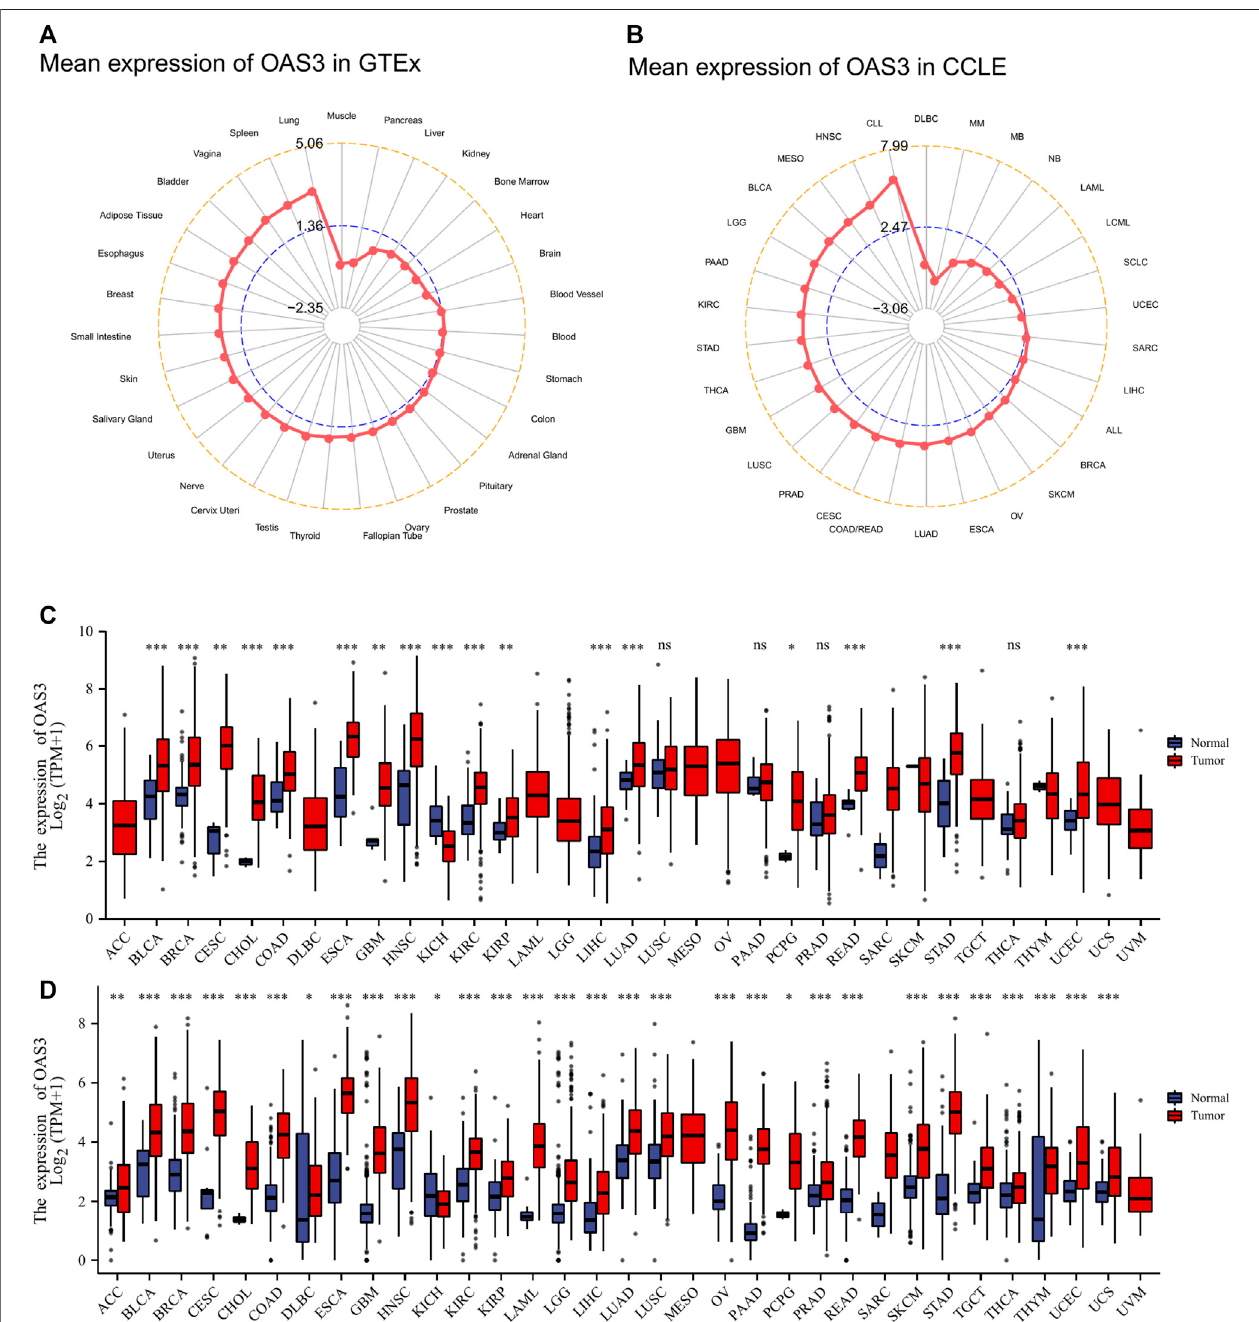
FIGURE 2 | (A) : OAS3 mRNA expressions in various normal human tissues from the GTEx database. OAS3 is most highly expressed in lung and least expressed in muscle. (B) : OAS3 mRNA expressions from the CCLE database. The results showed that OAS3 was highly expressed in most tumors. (C) : Boxplots showing differential OAS3 expression levels (log2TPM + 1) between tumor and adjacent normal tissues across TCGA database. * p < 0.05; ** p < 0.01; *** p < 0.001. (D) : Boxplots showing differential OAS3 expression levels (log2TPM + 1) between tumor and adjacent normal tissues across TCGA and GTEx database. * p < 0.05; ** p < 0.01; *** p < 0.001.